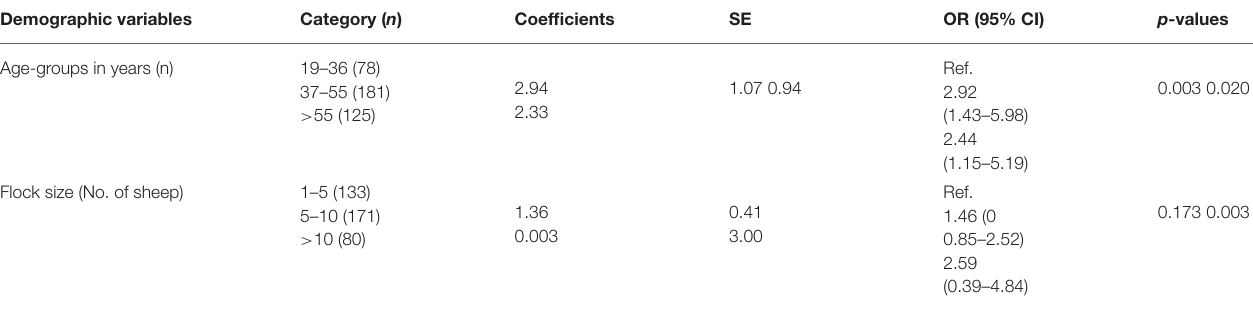
TABLE 8 | Final multivariable logistic regression model of factors associated with respondents’ knowledge about ovine pastuerellosis ( n = 384). Demographic